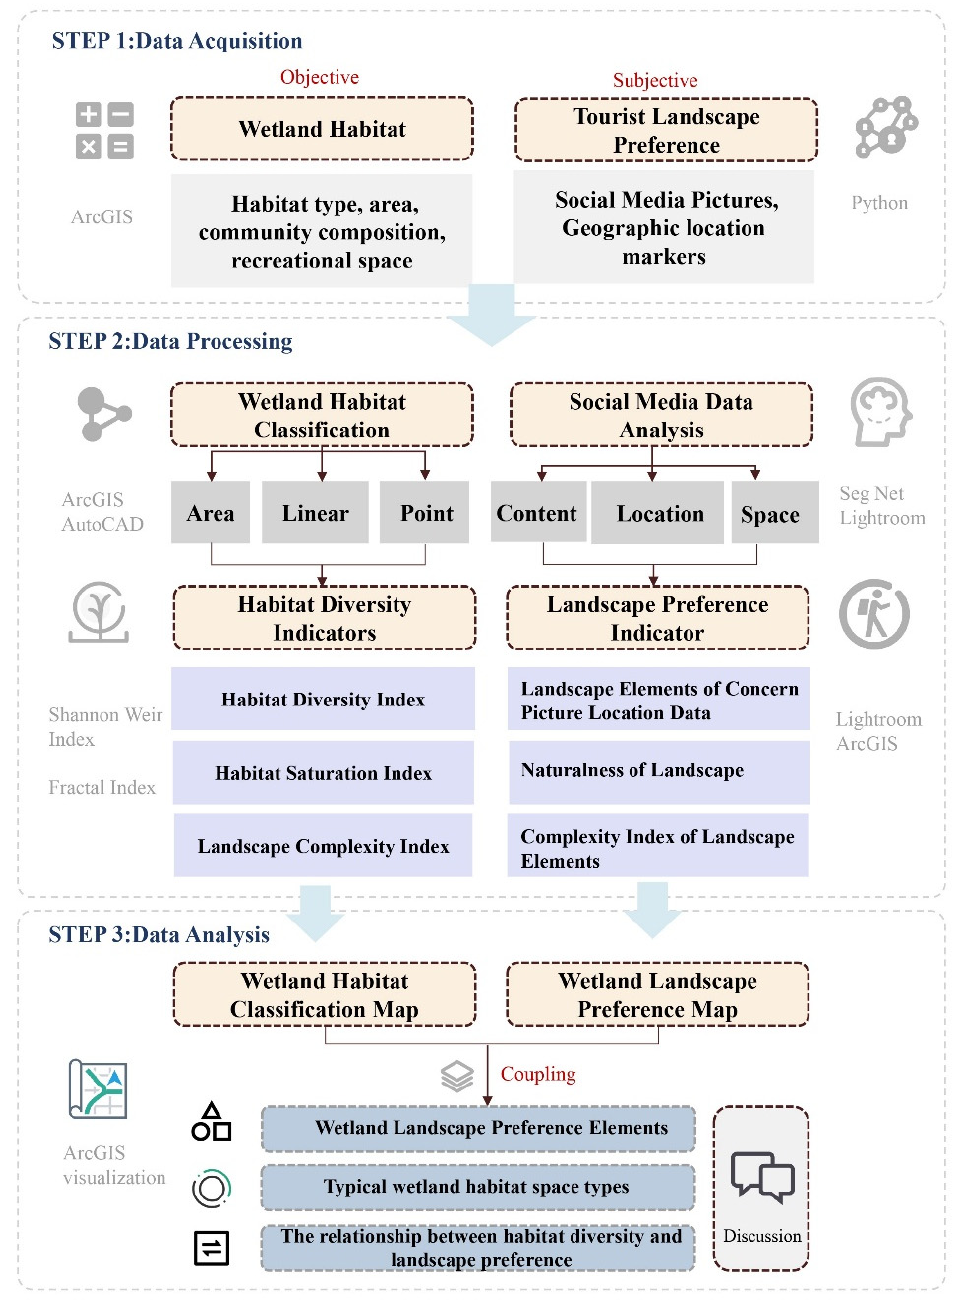
Figure 2. This shows the process for achieving the research objectives.